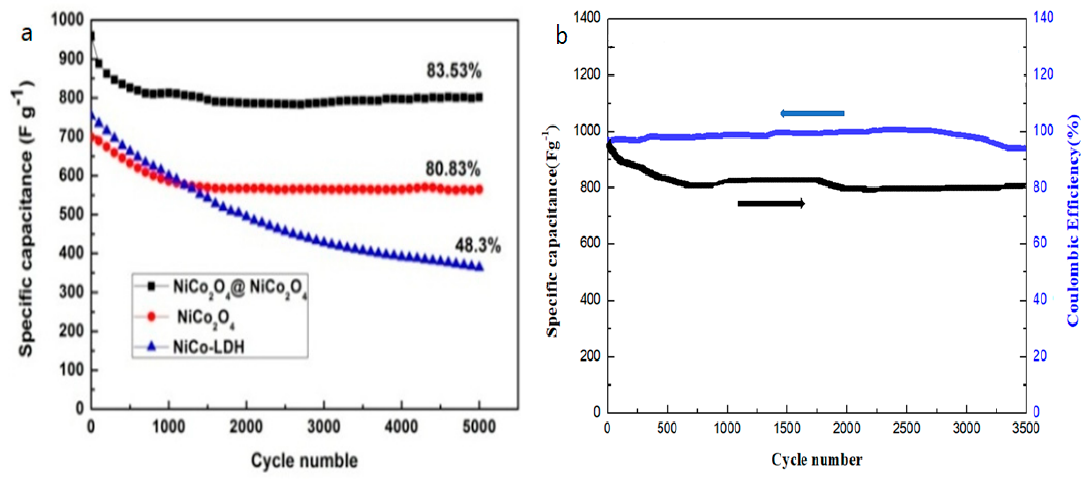
Figure 7. ( a ) Cycling stability test of different samples at 20 A g − 1 CD for 5000 cycles and ( b ) the NiCo 2 O 4 @NiCo 2 O 4 electrode’s cycling stability and Coulombic efficiency at a CD of 20 A g − 1 for 3500 cycles.